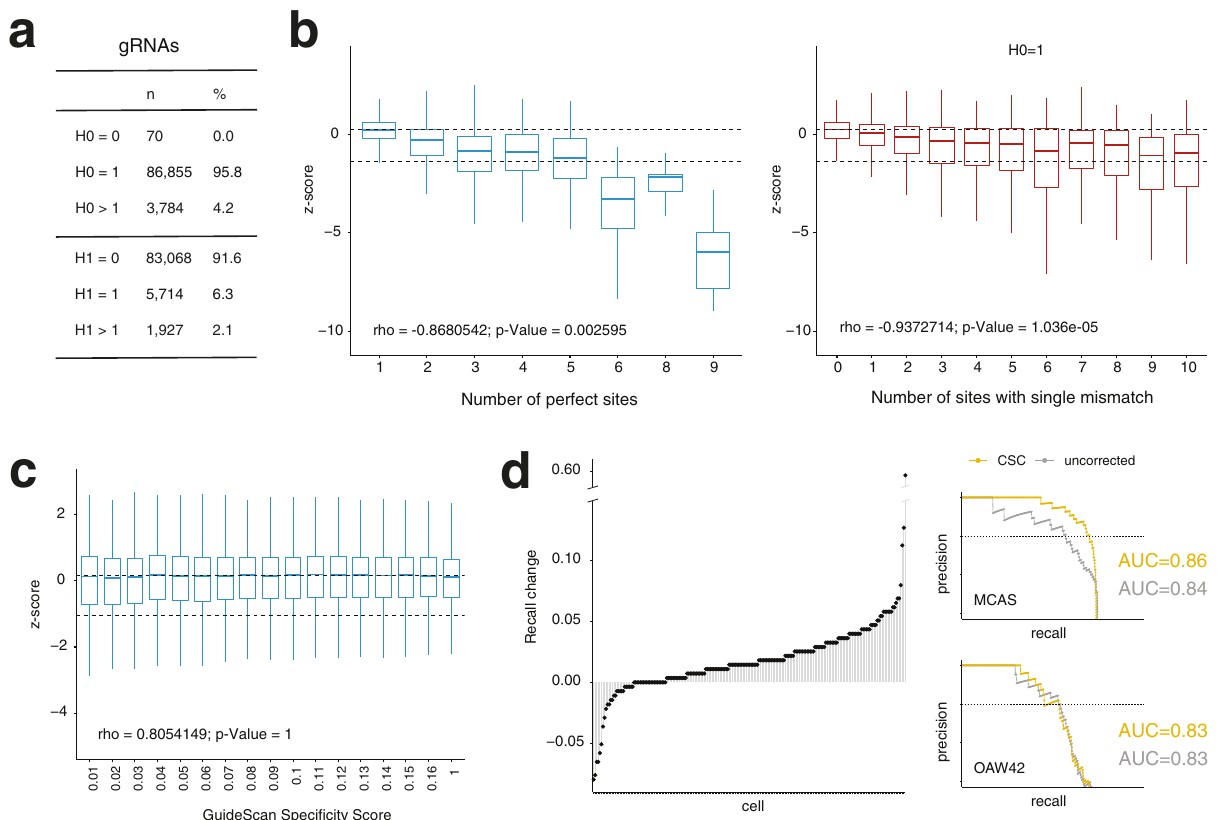
Fig. 5 Analysis of the Sanger dataset from Project Score. a Number and percentage of gRNAs in the Sanger library that have 0, 1, or more than 1 perfect targets (H0) in the human genome (hg38 assembly) or that have 0, 1, or more than 1 targets with a single hamming mismatch (H1). b Left, boxplots of z - scores of gRNA log 2 FC for all Project Score screens across multiple H0 bins (i.e., increasing numbers of perfect targets). Right, boxplots of z -scores for gRNA log 2 FC for all Project Score screens across multiple H1 bins (i.e., increasing numbers of targets with a single hamming mismatch) for gRNAs that have a single perfect targeting the genome (H0 = 1). Dashed lines indicate median depletion of speci fi c gRNAs (H0 = 1, H1 = 0) targeting known non- essential (top) or essential (bottom) genes. One-sided Pearson correlation values between mean depletion and number of off-targets, as well as the signi fi cance of the correlation are shown below. n = 324. c As in b but plotting z -scores of gRNA log 2 FC against GuideScan ’ s speci fi city bins. Speci fi city values correspond to highest value of each bin. Note how for 19-mer gRNAs there is no correlation between GuideScan ’ s score and depletion. One-sided Pearson correlation values between mean depletion and number of off-targets, as well as the signi fi cance of the correlation are shown below. n = 324. d Left, change in recall (5% FDR) for each Project Score screen after being corrected with CSC. On the right we show examples of precision-recall curves for screens showing increased recall (MCAS, second most improved) or decreased recall (OAW42, second most decreased) after correction. Dashed line highlights 0.95 precision value (which corresponds to a false discovery rate of 5%). Note how the improved recall in the MCAS screen is accompanied by an increase in the area under the curve (AUC). In contrast, the decreased recall in the OAW42 screen is accompanied by no change in the AUC. All boxplots show minimum, maximum, median, fi rst, and third